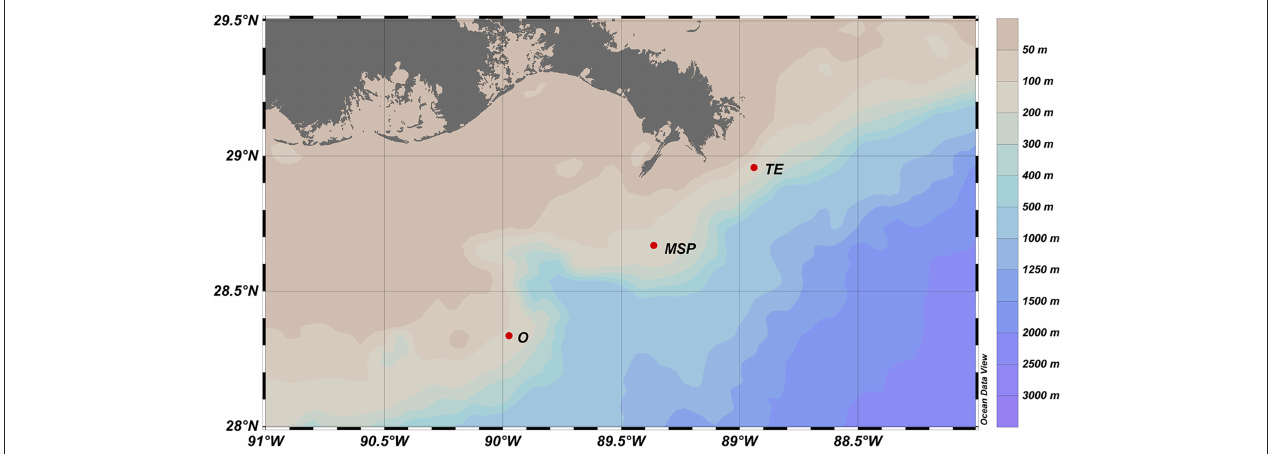
FIGURE 1 | Map of the sampling sites on the Louisiana shelf. See Table 1 for a detailed site description.